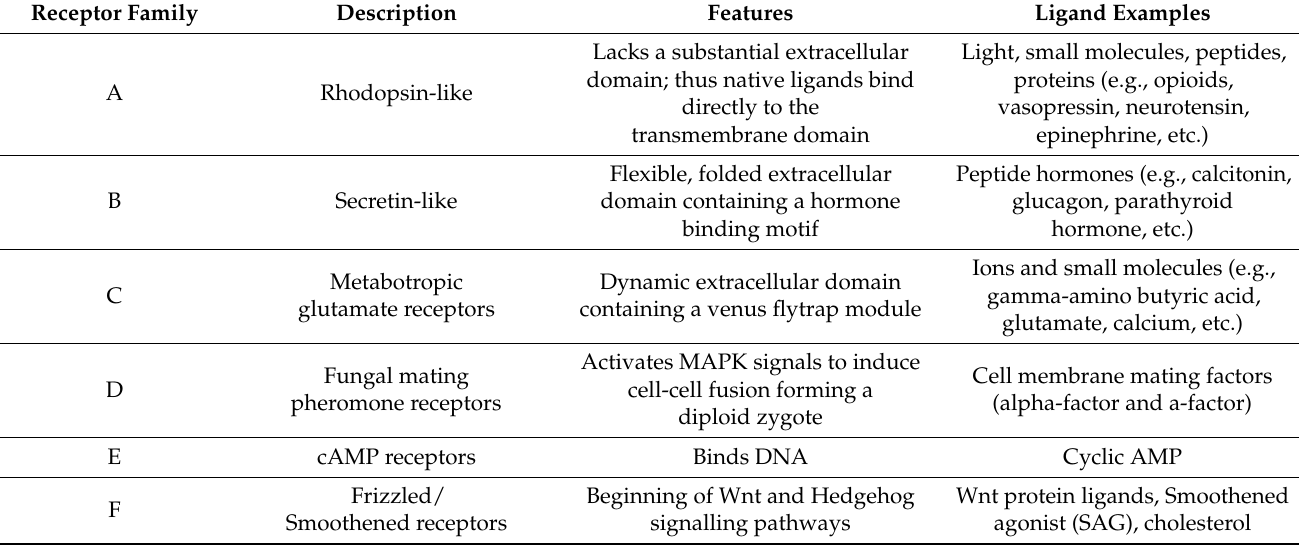
Table 1. A classification summary of the six G protein-coupled receptor (GPCR) families [7]. GPCRs are typically grouped based on sequence homology and functional similarity, though many are still considered ‘orphans’—receptors of unknown function or classification. Family D and E (found in fungi and slime moulds) are not understood as well as the other four families, due to their limited application to human prophylaxis; mammalian receptors have understandably taken priority with structural studies and pharmaceutical